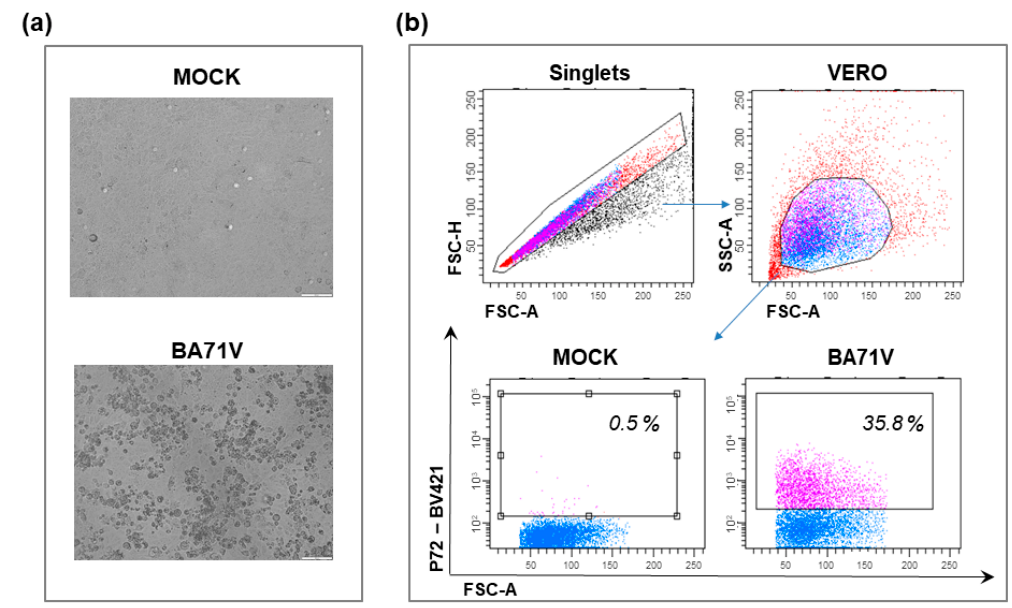
Figure 1. BA71V infection of VERO. VERO cells were infected with the avirulent BA71V ASFV strain using an MOI of 2, alongside mock-infected controls. At 48 h pi, the cytopathic effect was observed with microscopy ( a ) and percentages of ASFV late protein p72 + cells were assessed using flow cytometry ( b ). In panel a, representative images of mock-infected and BA71V-infected VERO cells are presented; scale bar 100 μ M. In panel b, the gating strategy and representative dot plots are displayed to demonstrate the p72 labeling of VERO cells infected with BA71V ASFV.